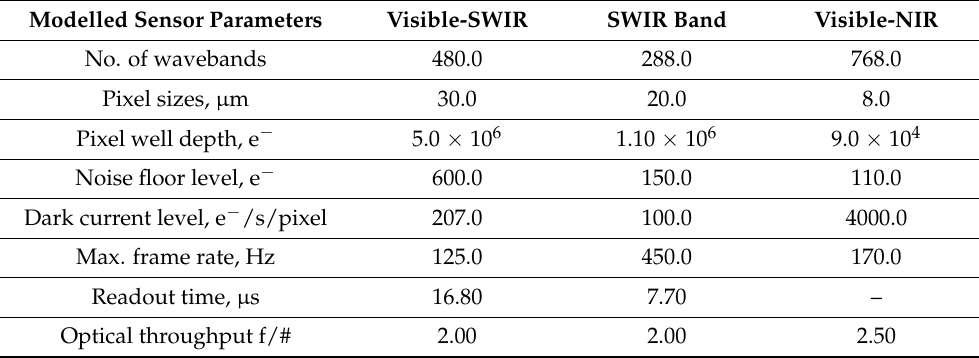
Table 1. A list of typical sensor characteristics and parameters that have been adopted for the modelled sensors in this work. Modelled Sensor Parameters Visible-SWIR SWIR Band Visible-NIR No. of